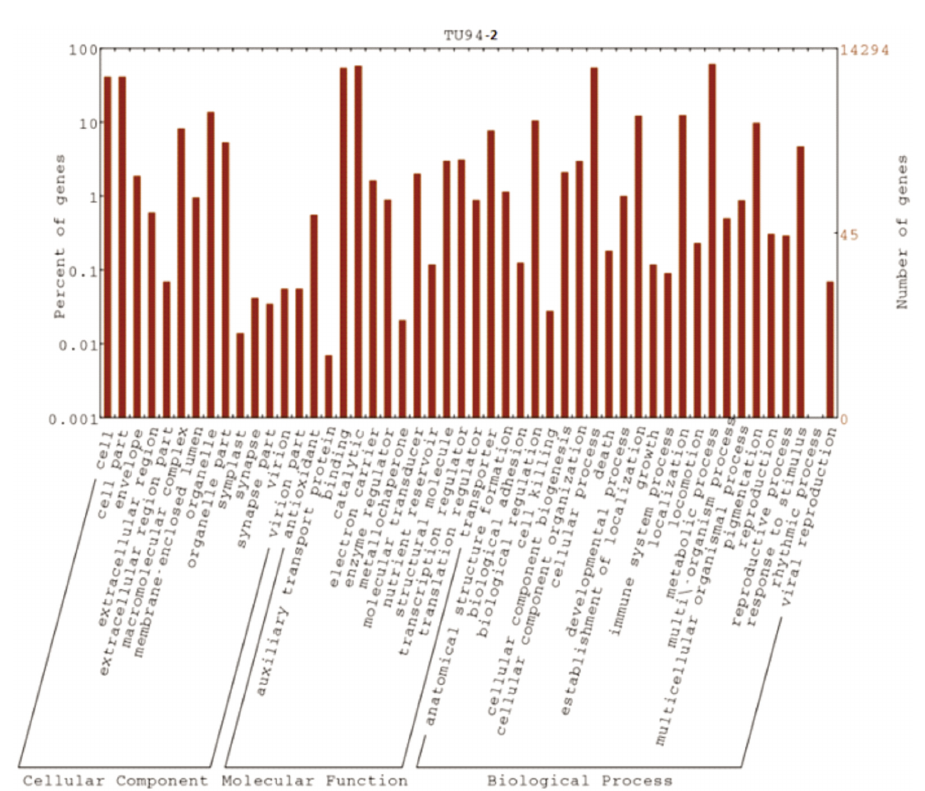
Fig 3. GO Annotation analysis for contigs from V . mungo